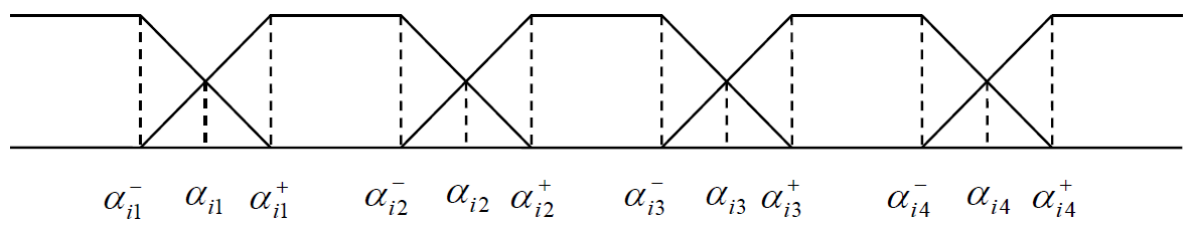
Figure 3. Diagram of increasing type membership